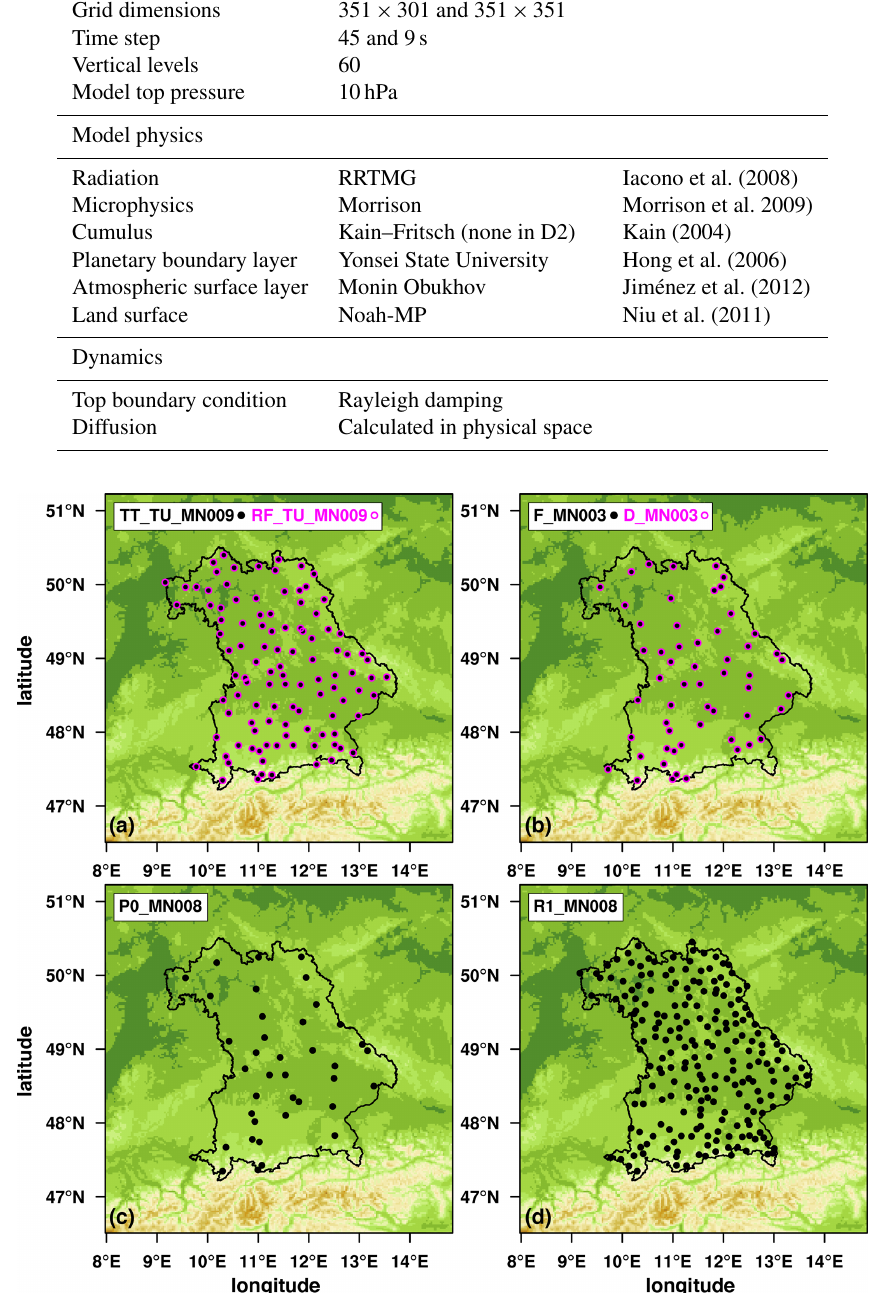
Figure 2. The location of the stations used for model evaluation during the most recent simulation year (September 2017 to August 2018) for each dataset listed in Table 2. Datasets labelled in black are shown by filled black circles, while datasets labelled in pink are shown by open pink circles, illustrating that locations for measurements of air temperature and humidity ( a ; TT_TU_MN009 and RF_TU_MN009) and of wind speed and direction ( b ; F_MN003 and D_MN003) were the same. The locations for measurements of surface pressure (P0_MN008) and of precipitation (R1_MN008) are shown in panels (c) and (d) ,